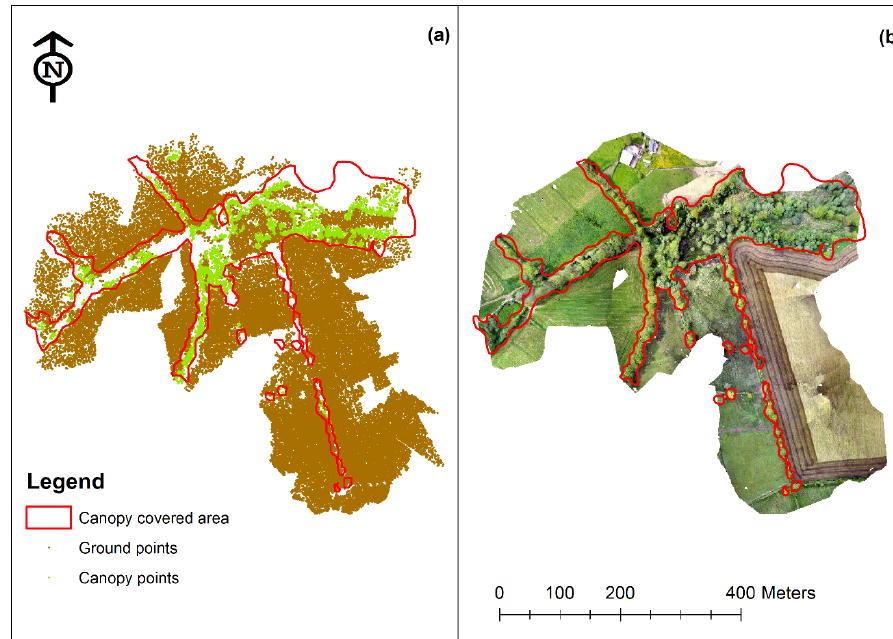
Figure 5. Showing ( a ) Classified SfM point cloud from and ( b ) Ortho ‐ photograph at the Meshaw site. Ground points are shown in brown while canopy points are shown in green.